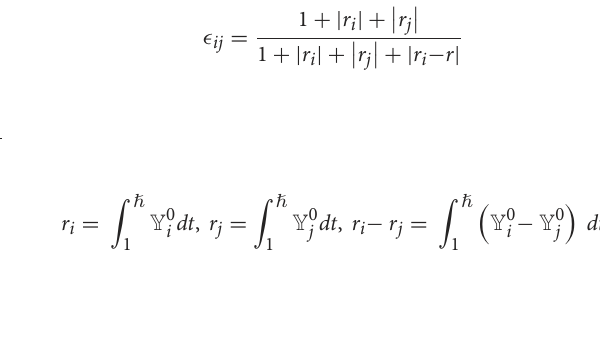
of the GRA model is depicted as γ ij or γ